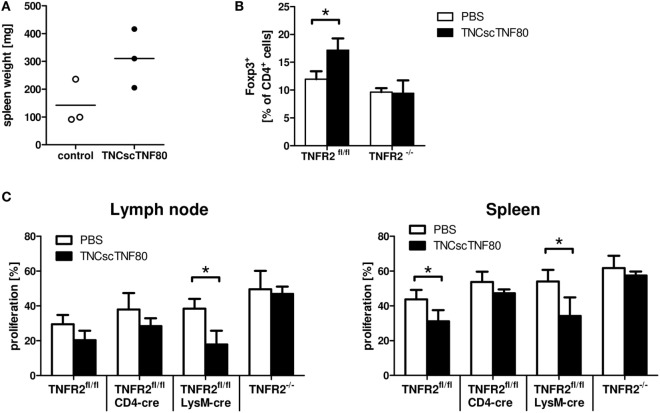
Effects of TNCscTNF80 in vivo. Naive mice received TNCscTNF80 (75 μg/mouse) two times (day 5 and 3). Spleen weight was determined on day 0. Data shown are from one experiment; each symbol represents a mouse (A). Naïve TNFR2fl/fl and TNFR2−/− mice were treated six times with either TNCscTNF80 (75 μg/mouse) or PBS. Three days after treatment, the percentages of splenic Treg cells (Foxp3+) were analyzed by flow cytometry. Results are shown as mean + SD of three individual mice per group. Data shown are from one experiment (B). Naïve TNFR2fl/fl, CD4cre/TNFR2fl/fl, LysMcre/TNFR2fl/fl, and TNFR2−/− mice were treated six times with either TNCscTNF80 (75 μg/mouse) or PBS. Two days after treatment cessation, carboxyfluorescein succinimidyl ester (CFSE)-labeled T cells were adoptively transferred and activated. Three days later, pooled cells from axial, brachial, and inguinal lymph nodes (left) and spleen cells (right) were analyzed by flow cytometry. Percentages of proliferating cells of CFSE-positive T cells in the indicated mouse lines were determined (C). Data are derived from one experiment and are shown as mean + SD of three to four individual mice per group.